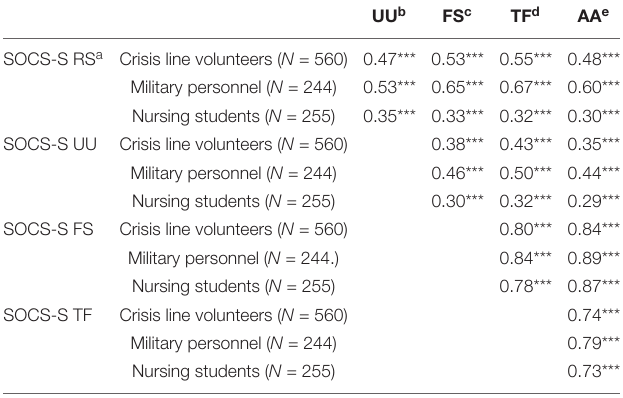
TABLE 2 | Pearson’s correlations between self-compassion subscales in three samples.